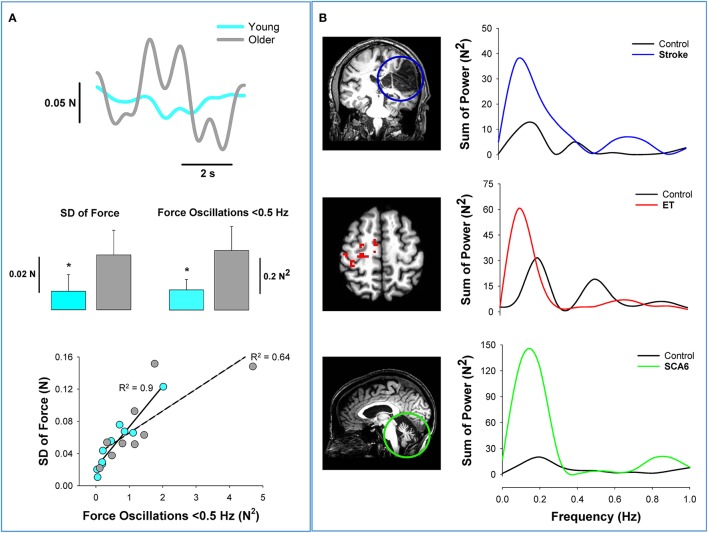
Low-frequency oscillations in aging and neurological disorders. Healthy aging and neurological disorders induce significant structural and functional changes in the brain. This figure shows how low-frequency oscillations increase with aging and brain pathology. (A) Force variability is greater in healthy older adults than young adults. The top row shows the variability in the force output from a young (light blue) and an older adult (gray) during a fine constant force contraction (2% maximum). In the middle row, we show that older adults exhibit greater variability of force (left) and greater oscillations in force below 0.5 Hz (right) (Fox et al., 2013). The bottom row shows that the oscillations in force contribute significantly to the force variability in both young (R2 = 0.9) and older adults (R2 = 0.64). (B) The argument that force oscillations below 0.5 Hz likely originate at the brain is supported from similar findings in patients with brain pathology. In the top row, we provide an example from stroke (Lodha et al., 2013). The coronal slice of the structural MRI scan shows a significant loss of cortical neurons (blue circle) in an individual post-stroke. The power spectrum of grip force (5% MVC) shows that the oscillations in force below 0.5 Hz are dominant in both the individual with stroke (blue) and healthy adult (black). Most importantly, the power from 0 to 0.5 Hz appear to quadruple following stroke. In the middle row, we provide an example from essential tremor (Neely et al., 2015). The axial slice of functional MRI scan shows significant cortical hyperactivity in individuals with essential tremor compared with healthy individuals. The power spectrum of pinch grip force shows that the oscillations in force below 0.5 Hz are dominant in both the individual with essential tremor (red) and the healthy adult (black). The power from 0 to 0.5 Hz appears to be double in the patient with essential tremor. In the bottom row, we provide an example from spinocerebellar ataxia type 6 (SCA6) (Casamento Moran et al., 2015). The sagittal slice of the structural MRI scan shows significant isolated cerebellar degeneration in SCA6. The power spectrum of ankle dorsiflexion force shows that the oscillations in force below 0.5 Hz are dominant in both the individual with SCA6 (green) and the healthy adult (black). The power from 0 to 0.5 Hz appears to be five times greater in the individual with SCA6. Together, the data from healthy older adults and from the individuals with brain pathology, suggest that the origin and regulation of oscillations in force below 0.5 Hz occurs at the brain level.